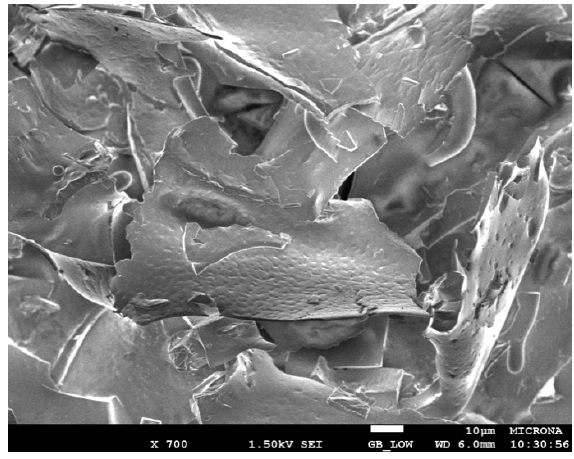
Figure 6. SEM Image of LipMatCCR11 in lyophilized form. Magnification 700×.